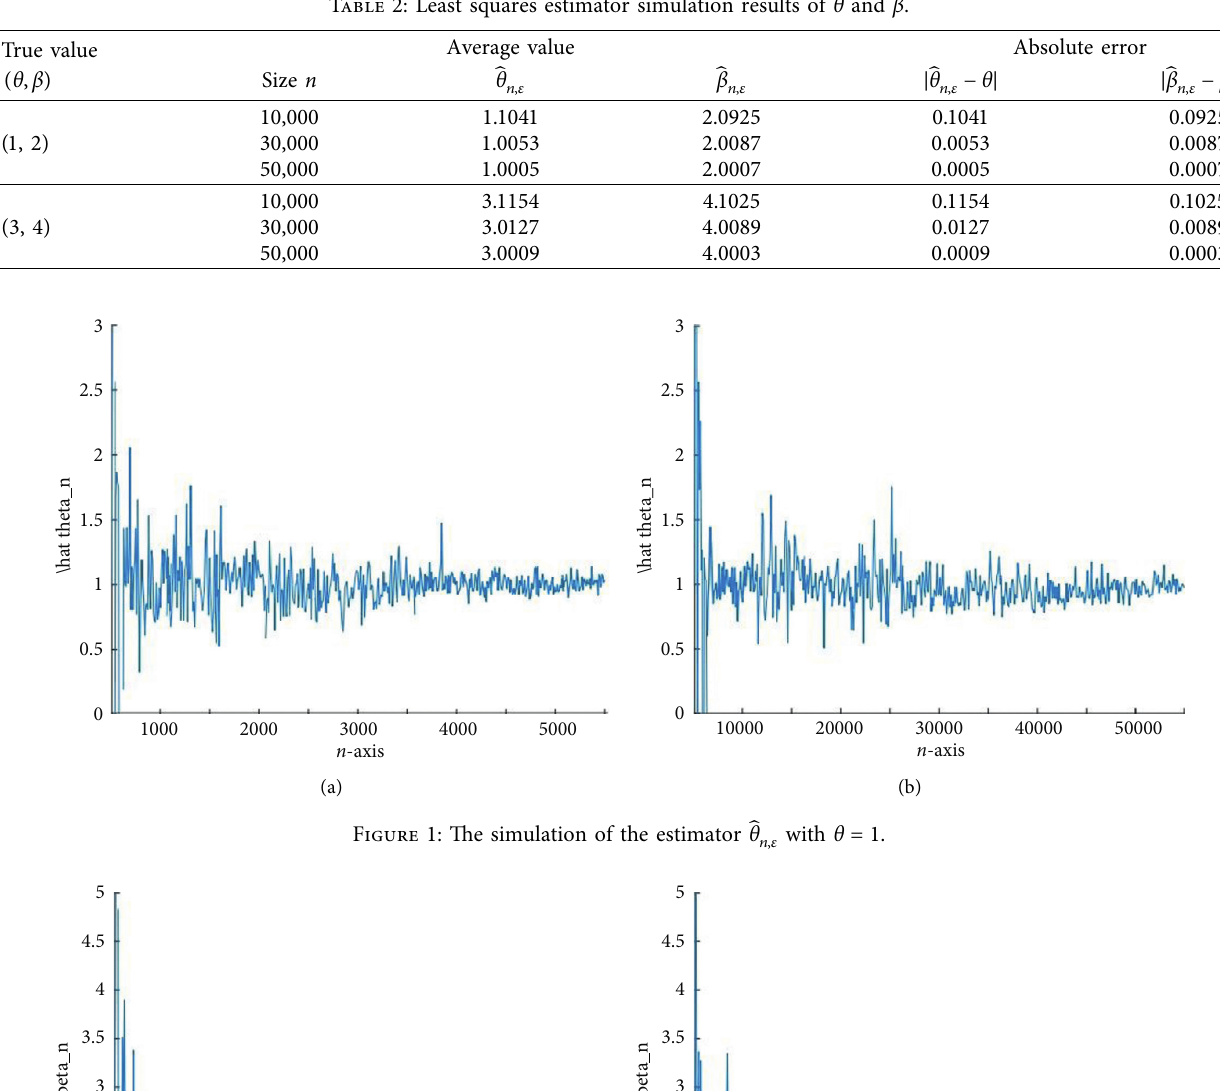
Table 2: Least squares estimator simulation results of θ and β .